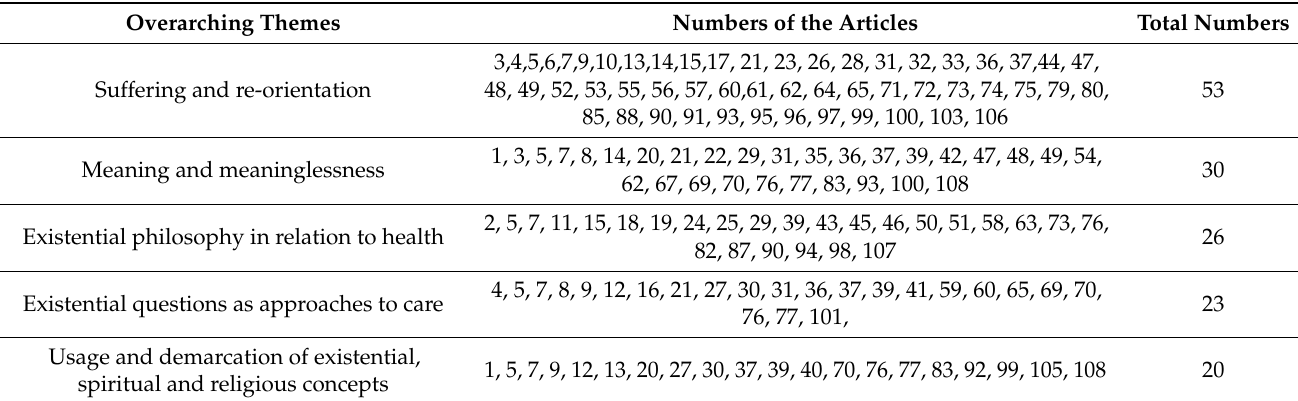
Table 4. Categorisation of overarching themes of the application of the ‘existential’. Overarching